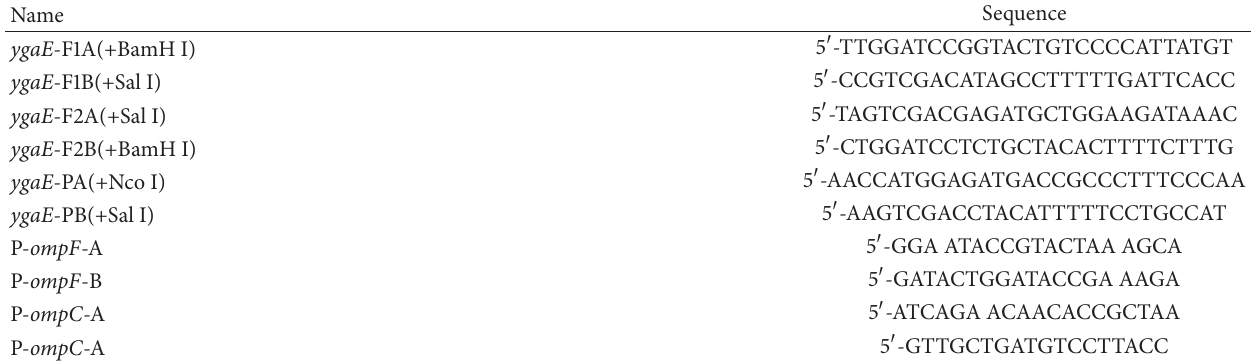
Table 2: Primers used in this